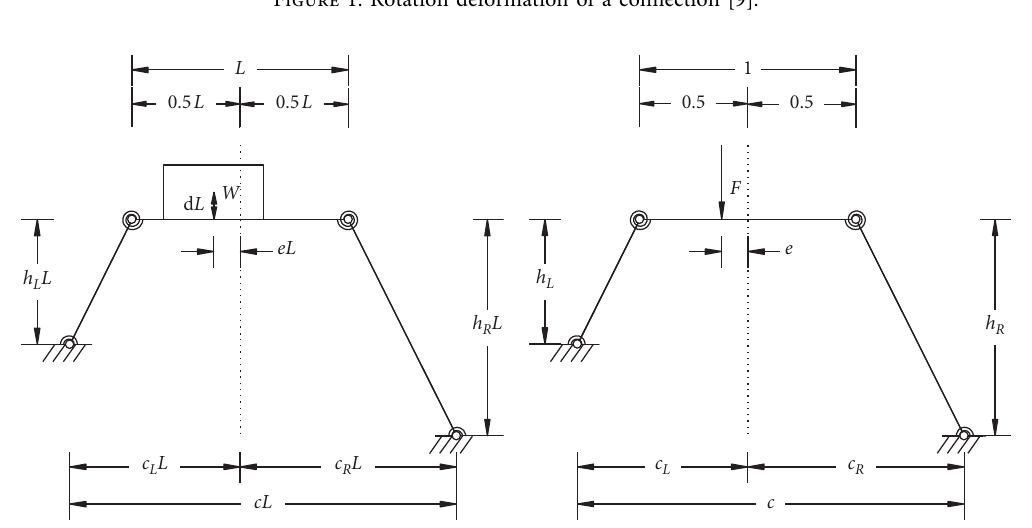
Figure 1: Rotation deformation of a connection [9].